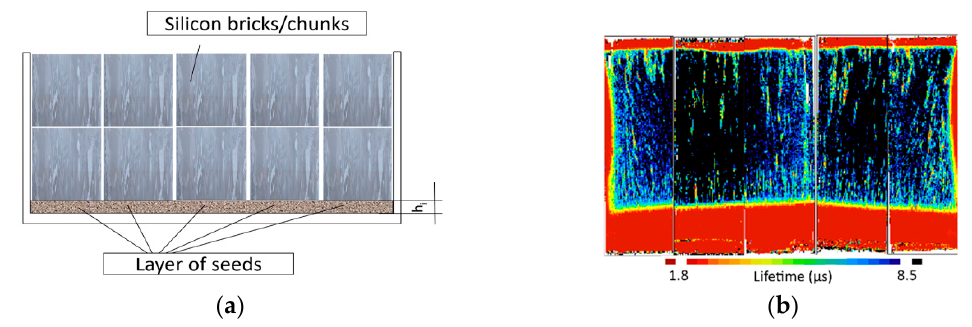
Figure 8. ( a ) Sketch of the charge of the directional solidification furnace. Crucible dimensions: 890 × 890 × 540 mm, layer of seeds h i = 50 mm; ( b ) Lifetime mapping of a representative